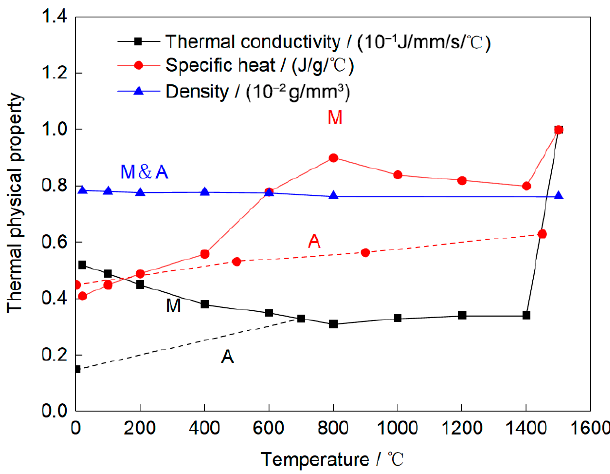
Figure 7. Temperature-dependent thermal properties of NM450TP wear-resistant steel (M, martensite; A, austenite).